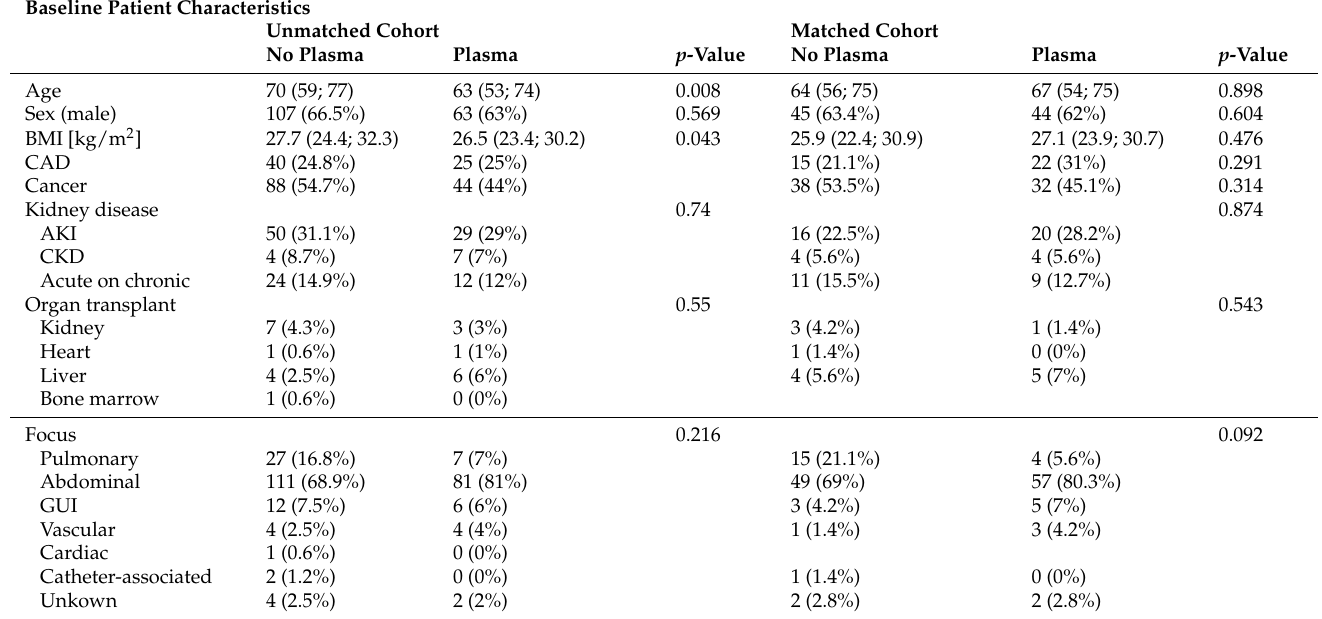
Table 1. Patient Characteristics: categorical values are given in absolute and relative frequencies, a Chi-Squared-Test was used for